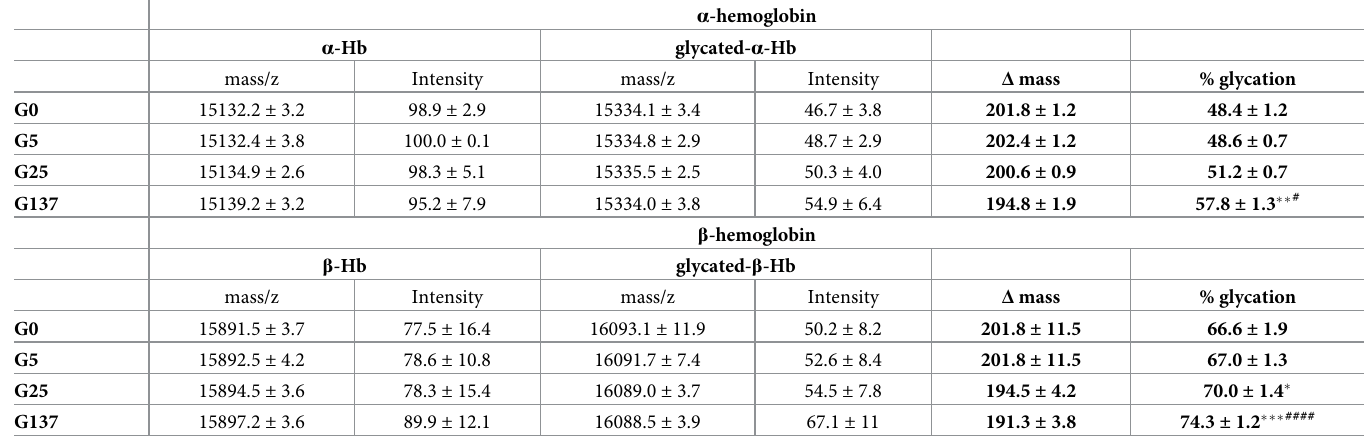
Table 2. Characterisation of glycation percentage in the different erythrocyte preparations by mass spectrometry. Data for the four main peak of the mass spectra corresponding to α -hemoglobin ( α -Hb; 15130 Da), glycated α -hemoglobin (g- α -Hb; 15330 Da), β -hemoglobin ( β -Hb; 15890 Da), glycated β -hemoglobin (g- β -Hb; 16100 Da) (S1 Fig—see supplemental data). G0, G5, G25 and G137 represent the four conditions of incubation to which erythrocytes were subjected: 0, 5, 25 and 137 mmol/l glu- cose, respectively. Δ mass and % glycation were calculated as explained in the methods section. Results are the mean ± SD and statistical analyses were performed